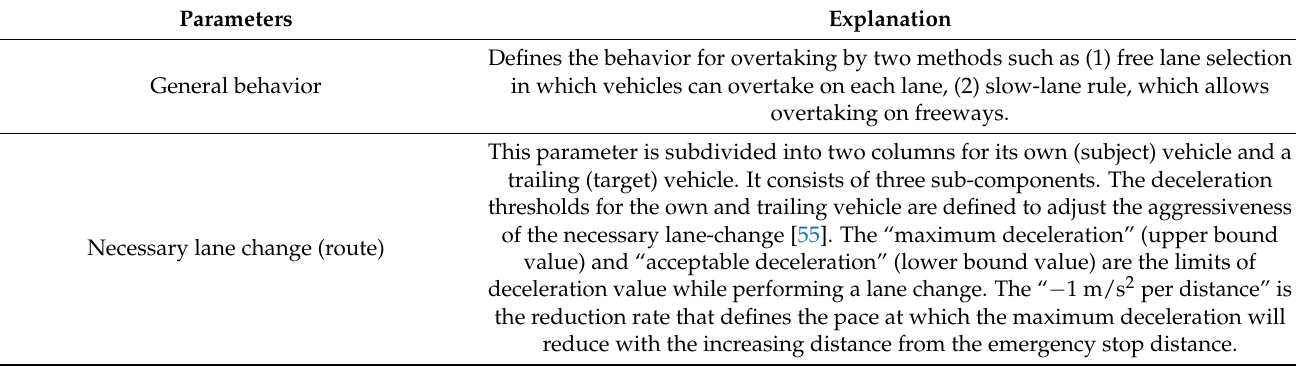
Table 6. Lane-change logic parameters